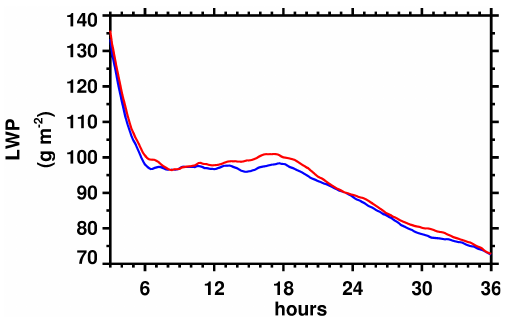
Fig. 17. Domain-averaged time series of liquid water path in simu- lation S • (blue) and S ¯•